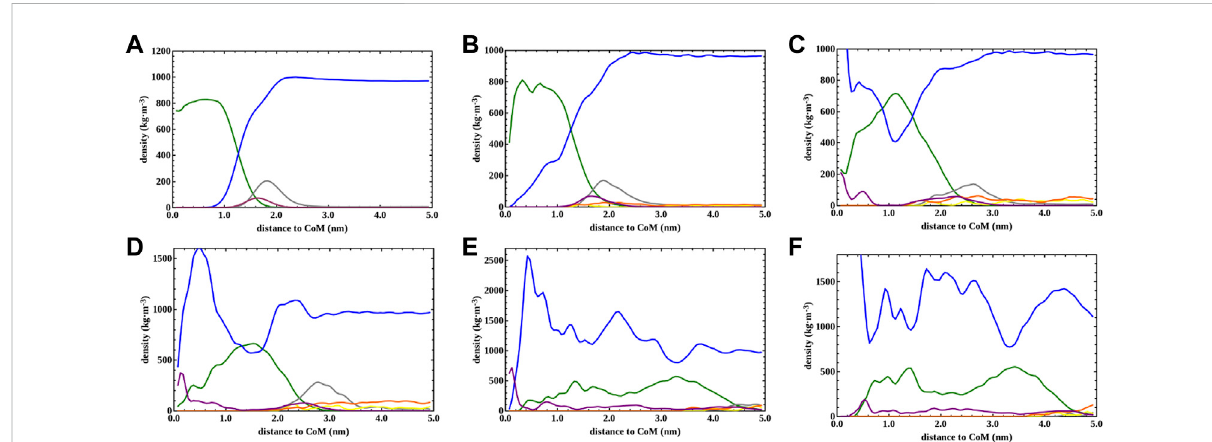
FIGURE 4 Averaged density pro fi lesoftheaggregates found intheCG-MD simulationsfor (A) 0.0, (B) 0.1, (C) 0.3, (D) 0.5, (E) 0.7 and (F) 1.0[N 4,4,4,4 ] + /[DS] - molar ratio systems shown in Figure 2. The last 0.5 μ s of the simulation was taken to obtain the density pro fi les. The color code is as follows: [DS] - alkyl tails and Sulphur charged headgroups are colored in green and purple, respectively. Sodium, chloride and water are in grey, yellow and blue, respectively, whereas [N 4,4,4,4 ] + was in